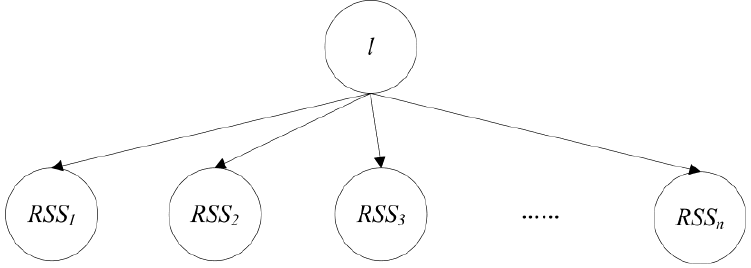
Figure 4. Structure of the naive Bayes classifier.